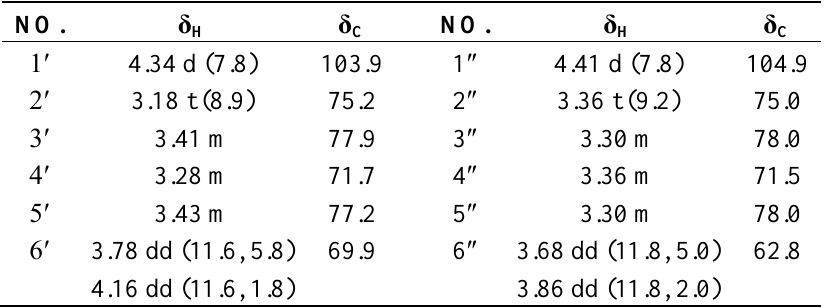
Table 3. 1 H- and 13 C-NMR data (400/100 MHz) data of the glycosyl groups for 3 (in CD OD, δ in 3